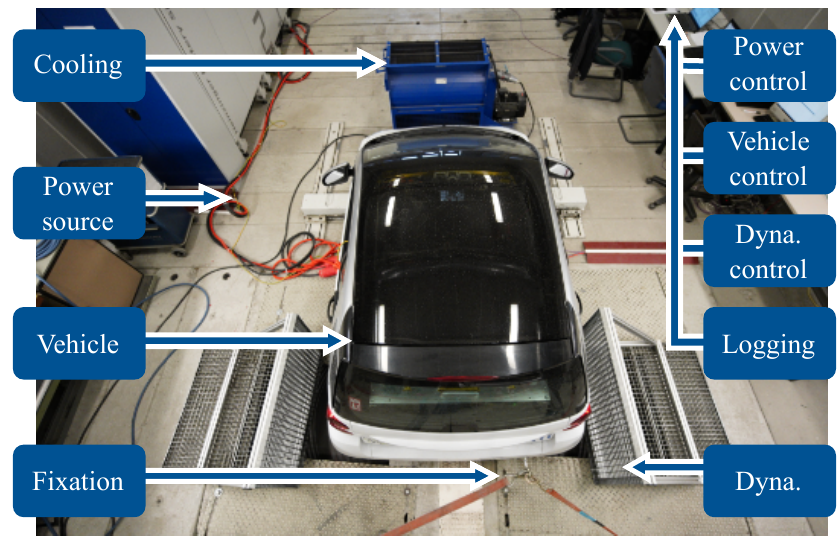
Figure 5. Test setup of prototype electric vehicle NEmo on roller dynamometer.